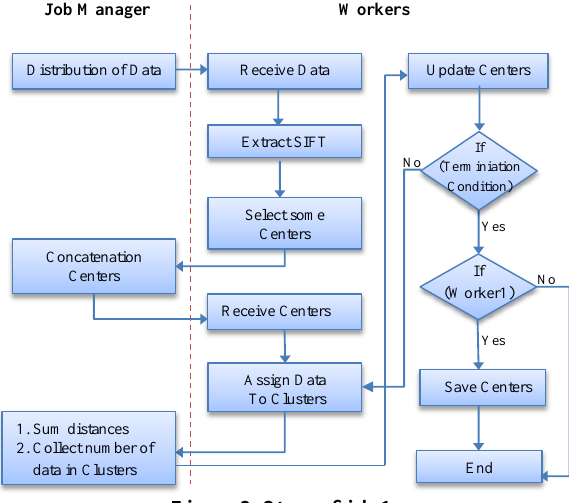
Figure 3. Steps of job